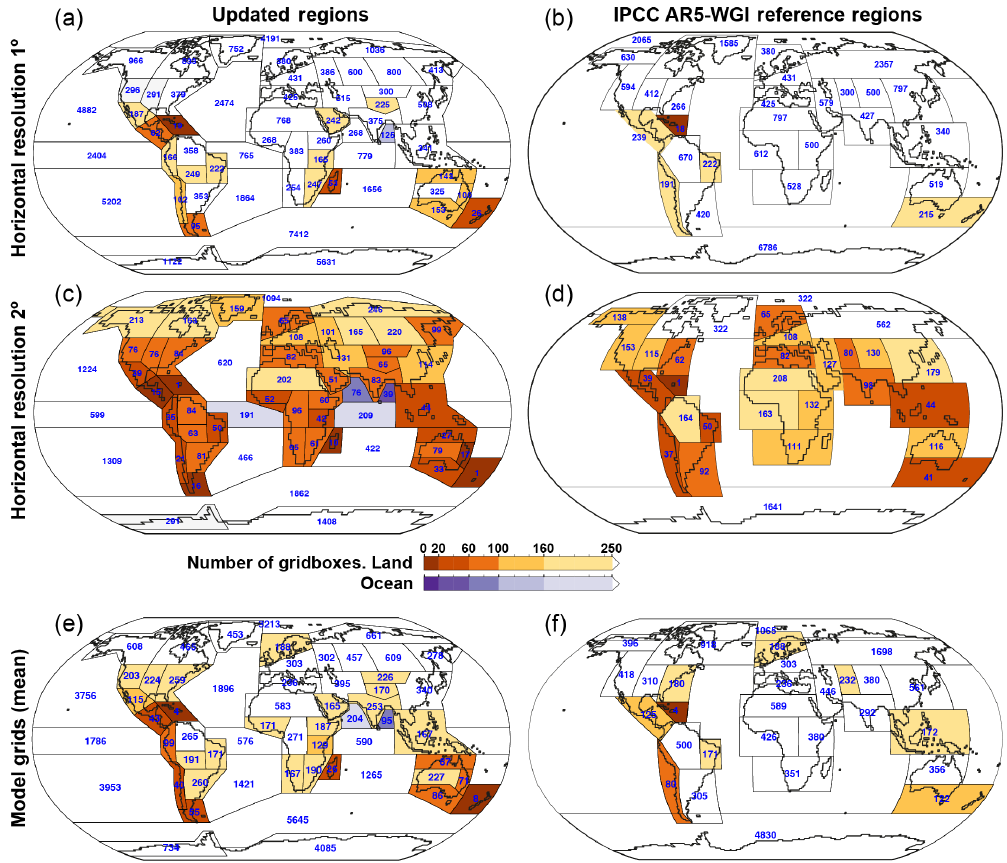
Figure 5. Number of grid boxes encompassed by the different reference regions for 1 ◦ (a, b) and 2 ◦ (c, d) resolution and for the CMIP6 model grids (e, f) – the multi-model mean is represented – considering the updated (a, c, e) and the original AR5 (b, d, f) reference regions. Colours indicate regions with fewer than 250 grid boxes. The blue numbers in each of the regions show the number of grid boxes (only land grid boxes for land